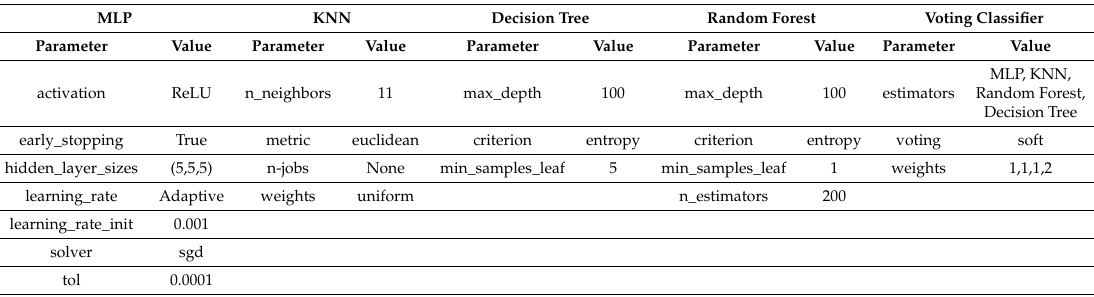
Table 2. Hyper-parameters of ML/DL